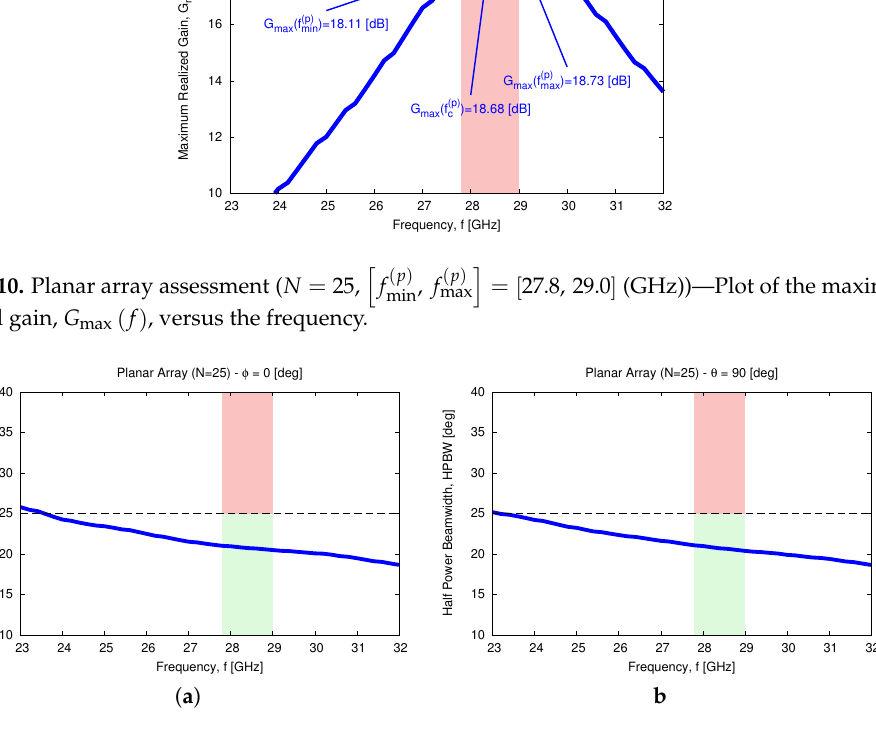
Figure 11. Planar array assessment ( N = 25, versus the frequency along the ( a ) azimuthal (i.e., φ = 0 deg) and ( b ) the elevation (i.e., θ = 90 deg)